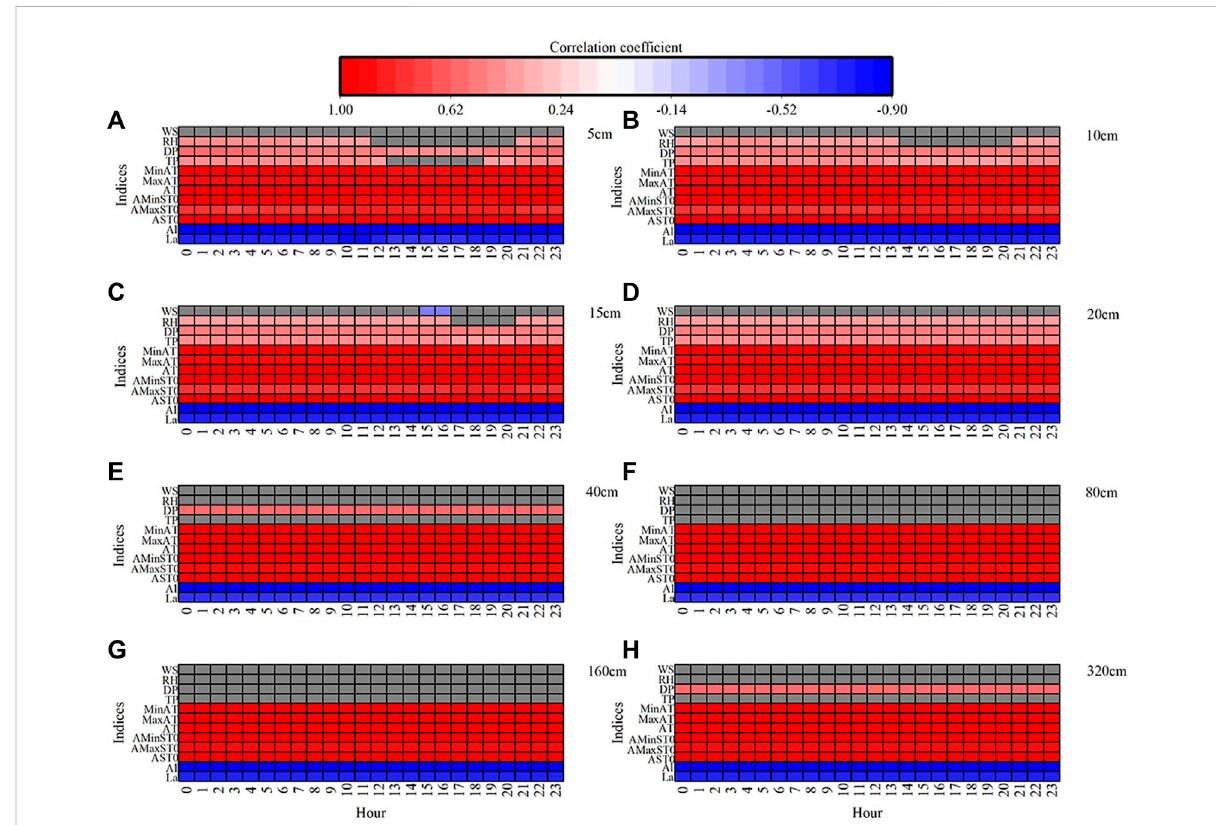
FIGURE 15 Spearman correlation coef fi cients between soil temperature at depths of 5 (A) , 10 (B) , 15 (C) , 20 (D) , 40 (E) , 80 (F) , 160 (G) , 320 (H) cm and climatic factors at00:00 – 23:00for average values of 2004 – 2020 (La, latitude; Al, altitude;AST0, 0 cm average surface temperature; MaxST0, 0 cm average maximum surface temperature; MinST0, 0 cm average minimum surface temperature; AT, average air temperature; MaxAT, average maximum air temperature; MinAT, average air minimum temperature; TP, total precipitation; DP, daytime precipitation; RH, relative humidity; WS, average wind speed; gray shading indicates no